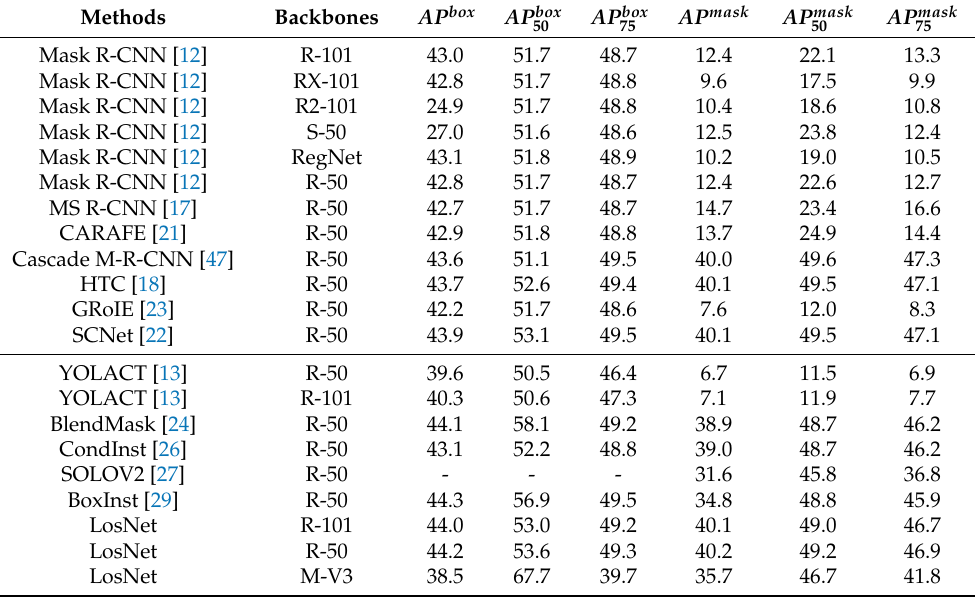
Table 7. Comparison of accuracy with the state-of-the-art methods on ore image datasets.